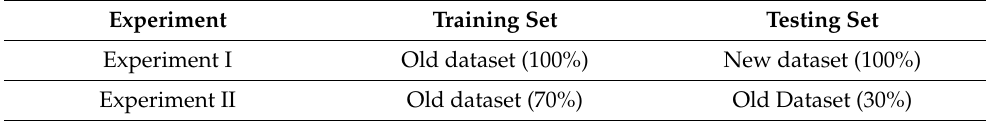
Table 7. Dataset Distribution for the Experiments of Part